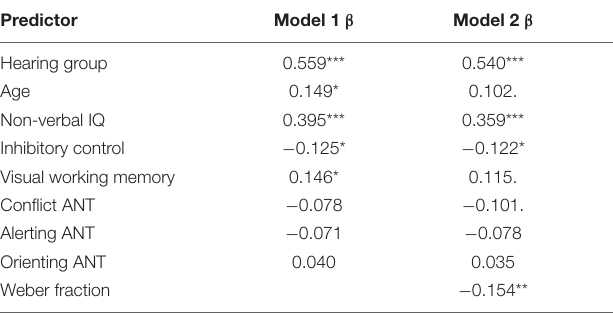
TABLE 3 | Standardized coefficients from regressions predicting mathematics